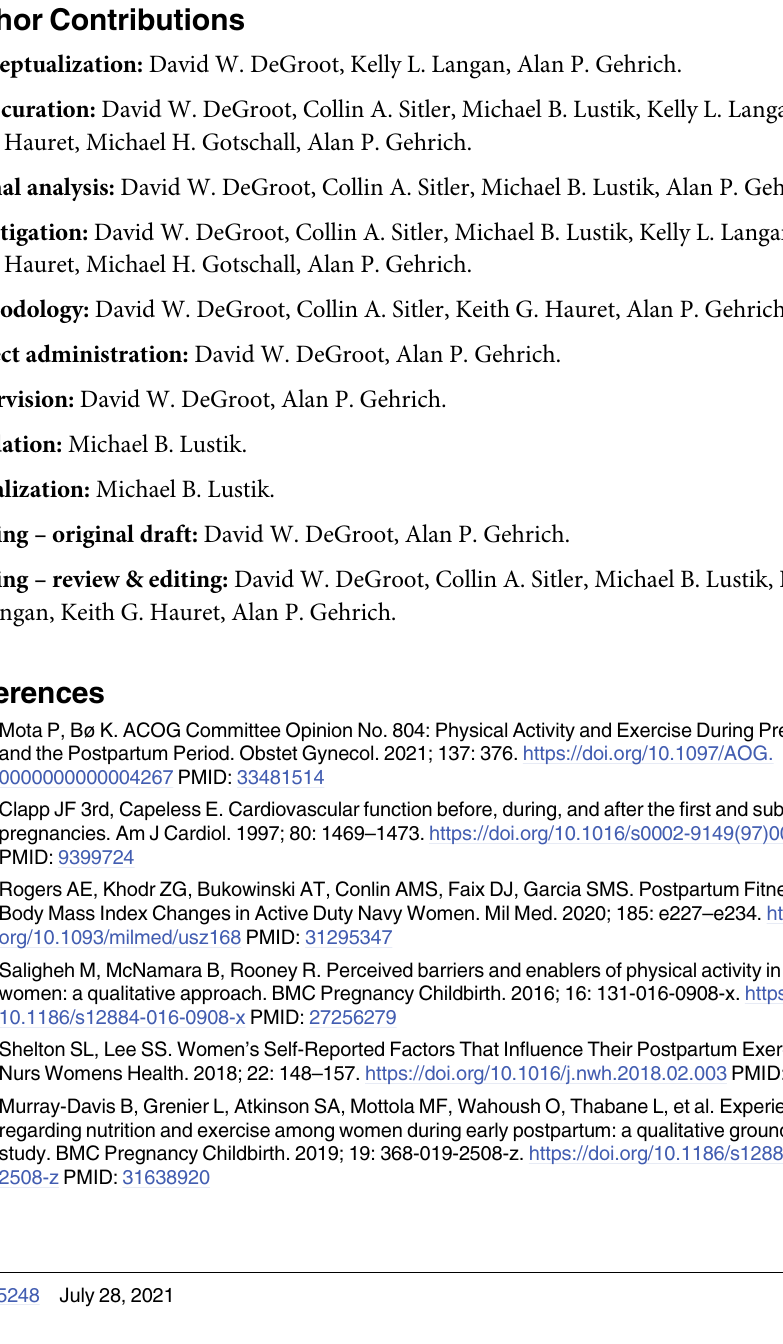
S1 Table. Pregnancy active duty and physical training